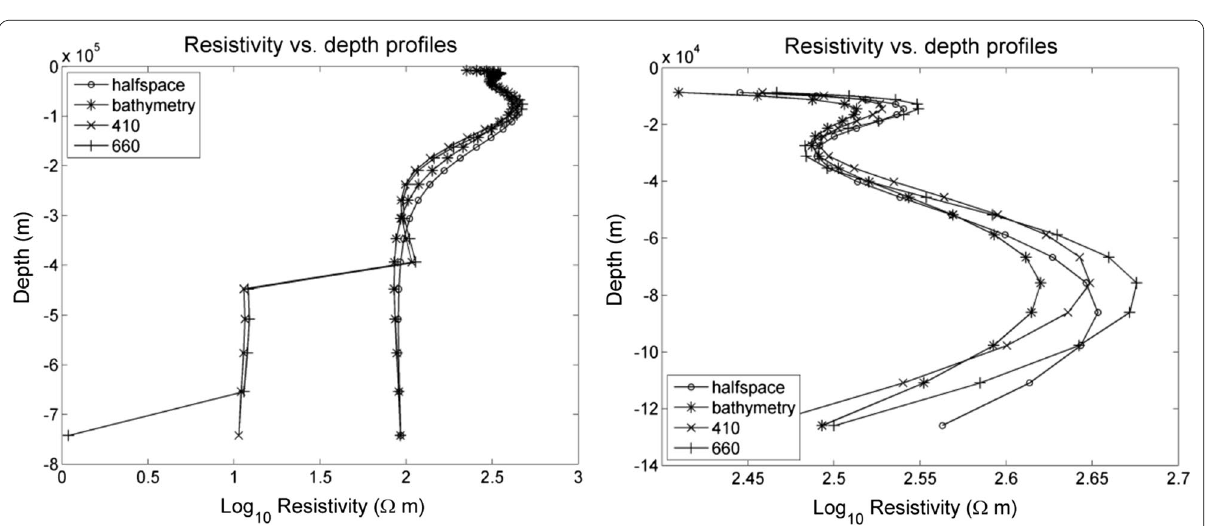
Bath and seds includes sea water with resistivity of 0.3 (cid:31) m and linearly increasing resistivity to a depth 2 km beneath the ocean bottom where it reaches the half- space resistivity. The 410 km prior model has resistivity decreased to 10 (cid:31) m beneath the 410 km seismic discontinuity. The 660 km prior model has resistivity of 10 (cid:31) m beneath 410 km and 1 (cid:31) m beneath 660 km. Each model had a starting RMS of 47.5